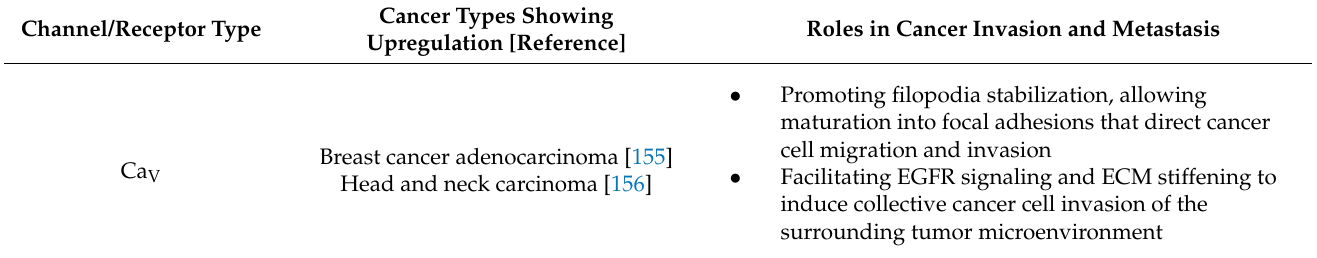
Table 2. Proposed roles for ion channels in elevating invasion and metastasis in different types of cancers, with cited references in